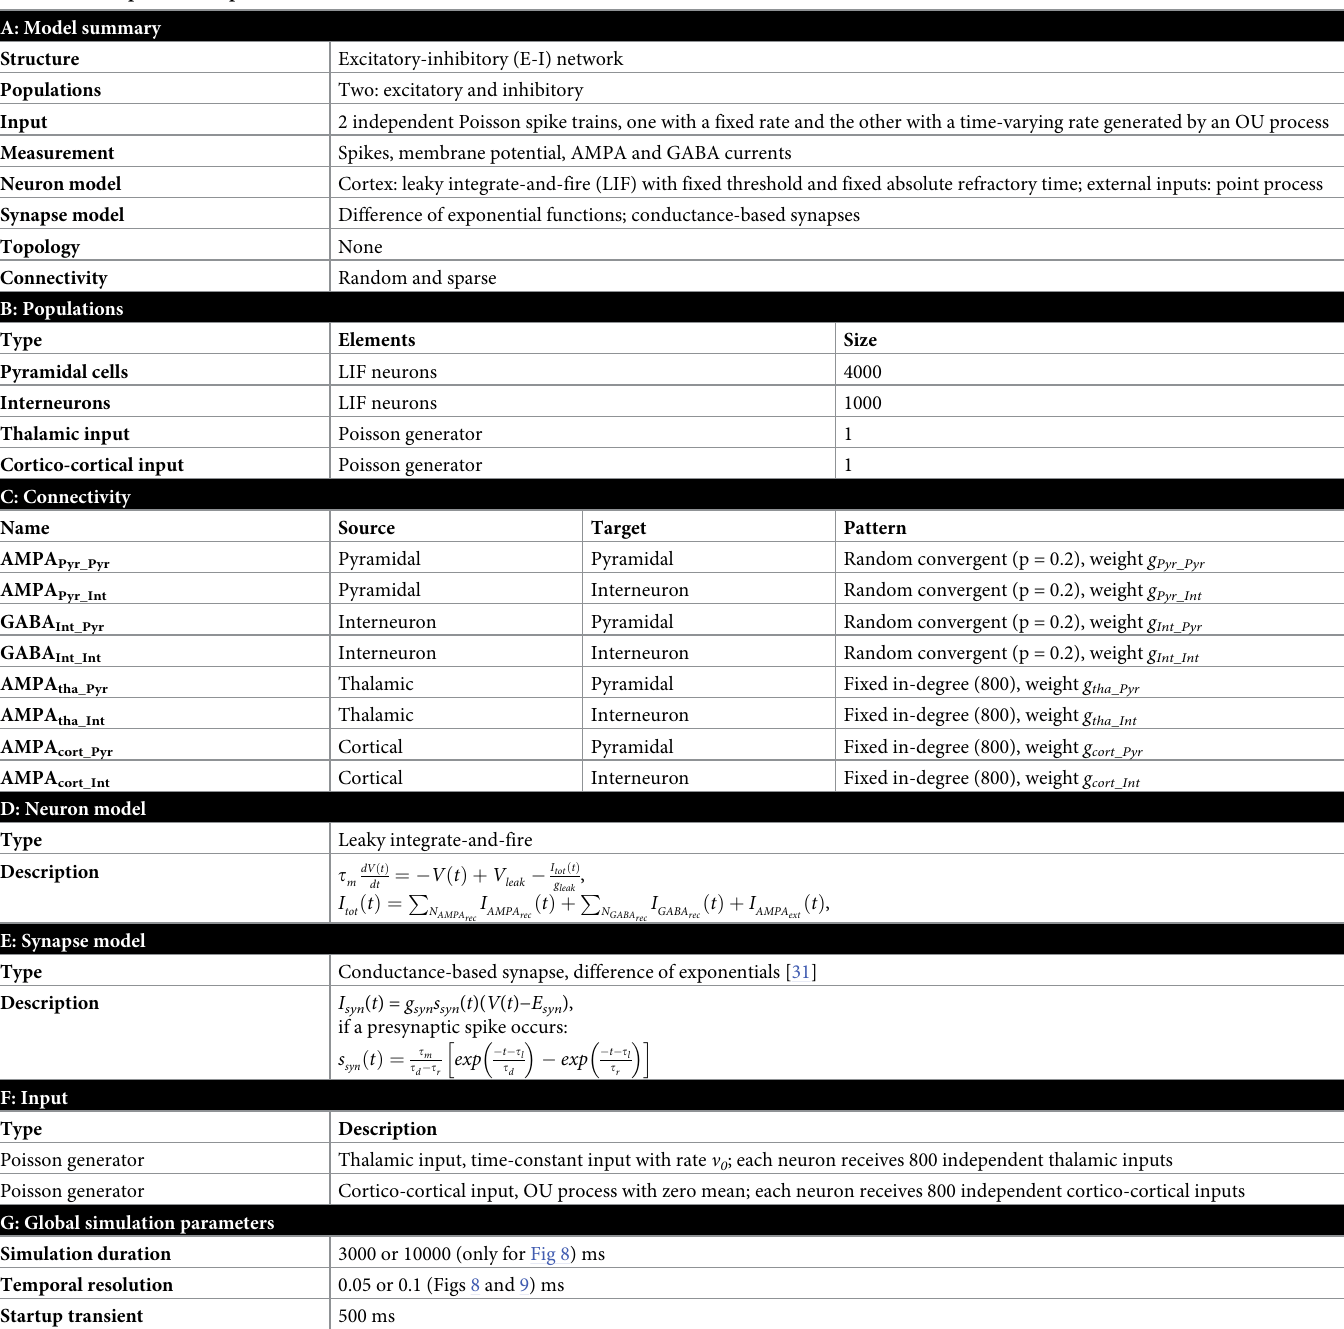
Table 3. Description of the point-neuron